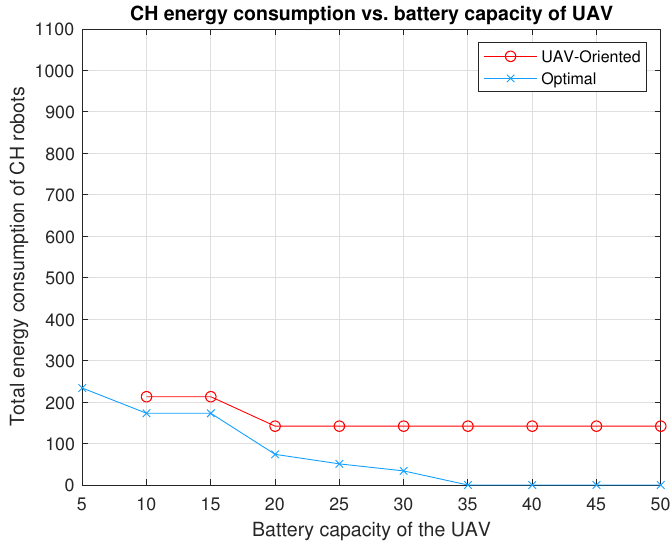
Figure 6. The total energy consumption of the seven CH robots in Figure 5 under the strategies, UAV-oriented and optimal for varying battery capacities of the UAV from B = 5 × C UAV to B = 50 × C UAV .